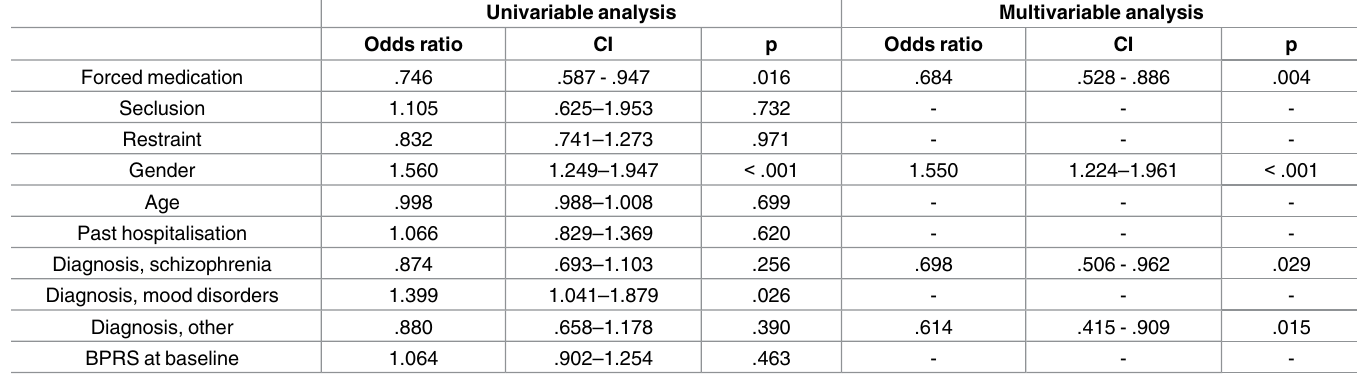
Table 1. Logistic regression analysis of association between coercivemeasures(and other variables) and retrospective justification of index admission after 3